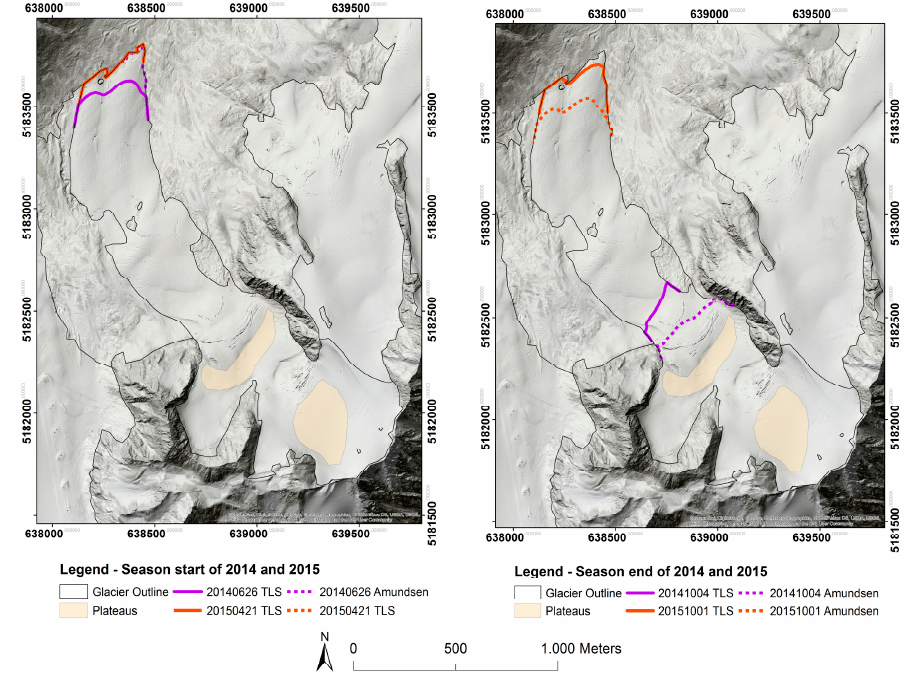
Figure 6. AMUNDSEN and TLS snowline comparison of the start and end of the season. The two plateaus are outlined in orange.